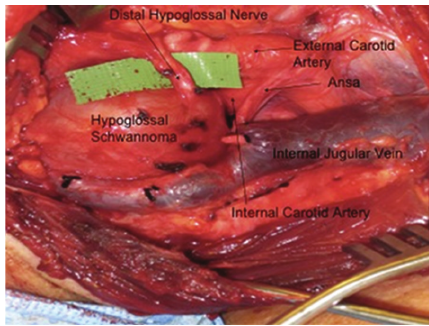
Figure 3: Intraoperative photograph demonstrating a mass origi- nating from the proximal segment of hypoglossal nerve, with the distal segment clearly seen exiting the